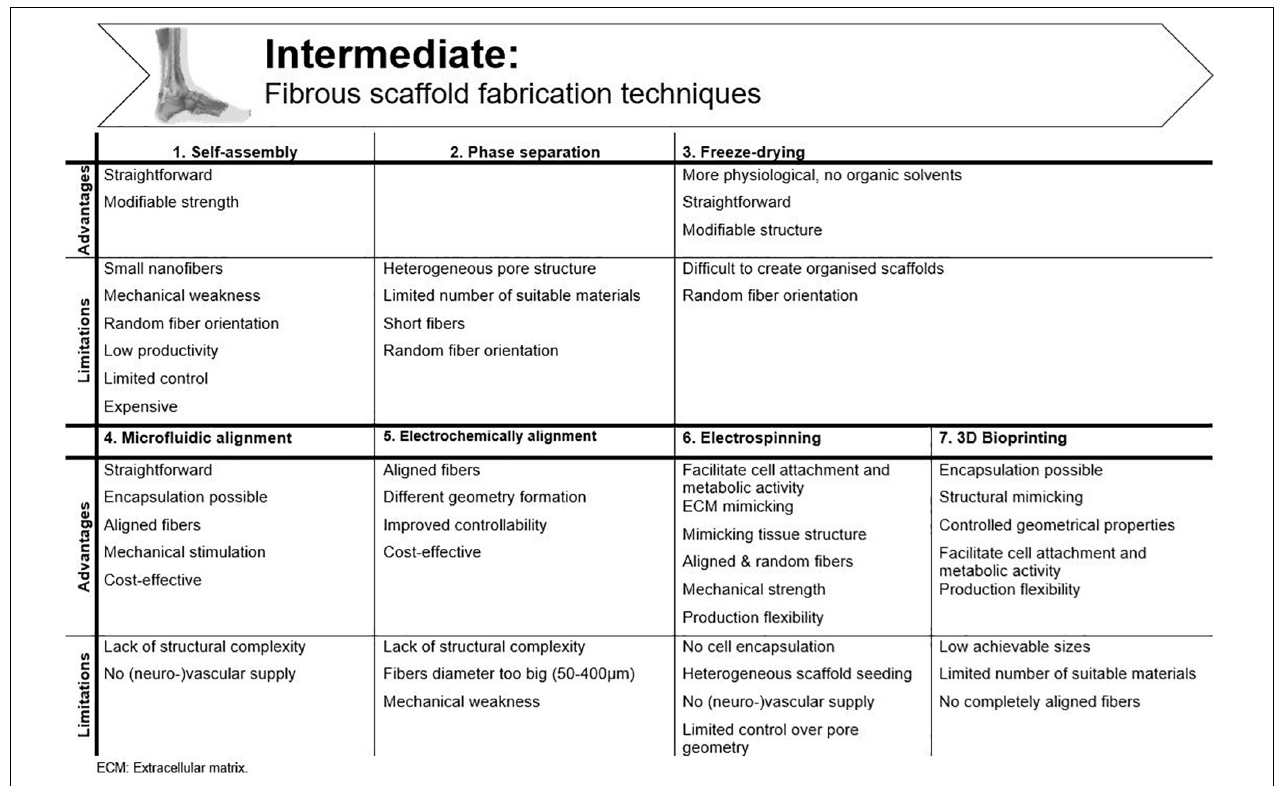
FIGURE 5 | Advantages and disadvantages of the available fibrous scaffold fabrication techniques for tendon tissue